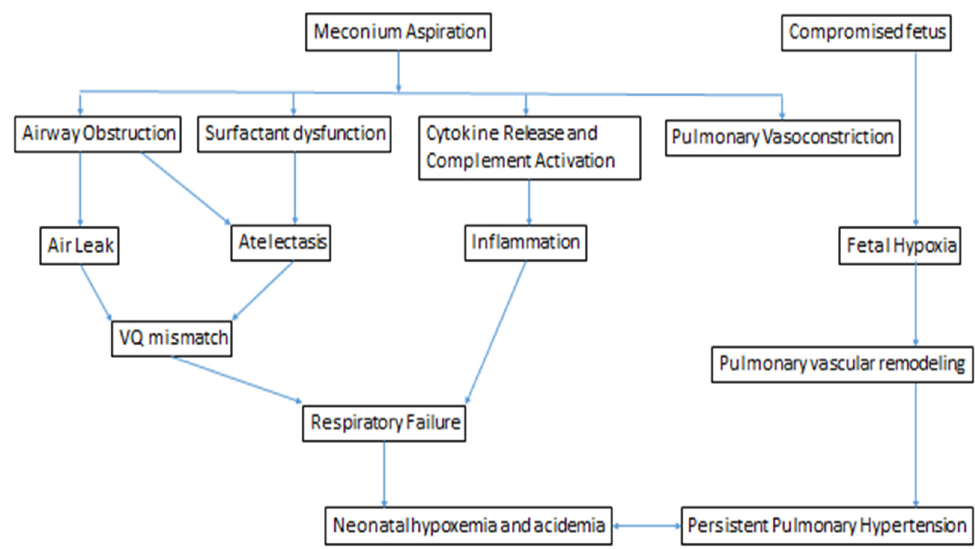
Figure 1. Pathophysiology of persistent pulmonary hypertension of the newborn as a result of fetal compromise and meconium aspiration.